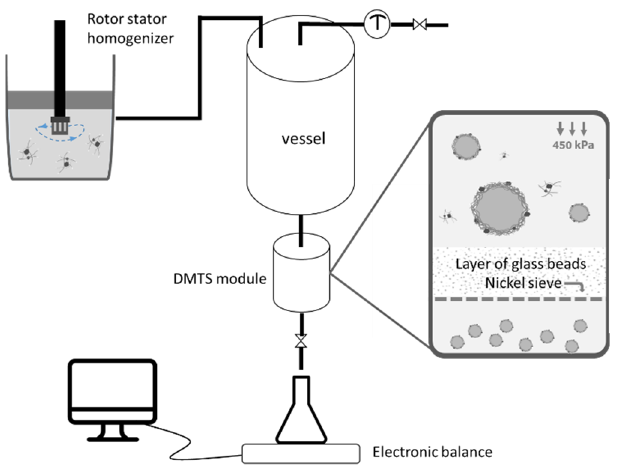
Figure 1. Premix emulsification and dynamic membrane of tunable pore size emulsification setup.